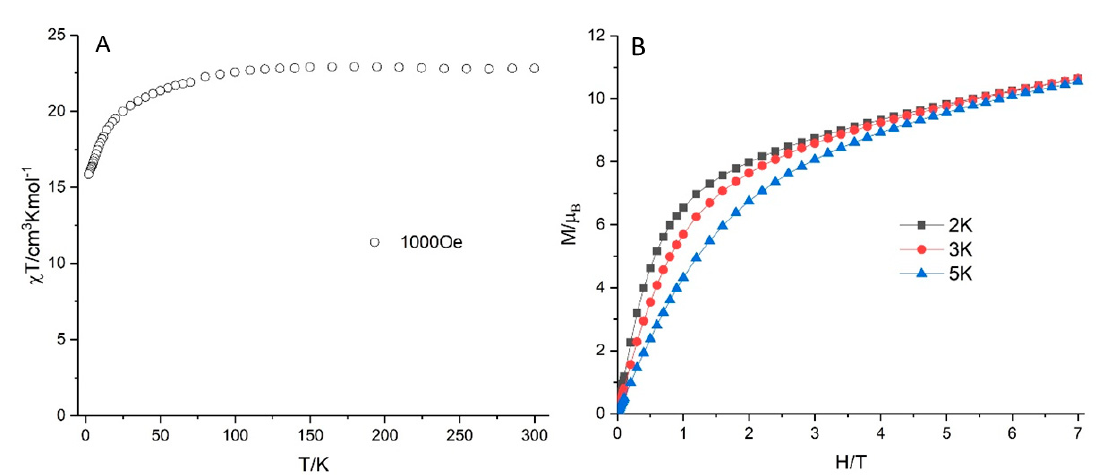
Figure 7. Plot of χ T vs. T under 1000 Oe applied DC field ( A ) and plots of M vs. H ( B ) for 1 .